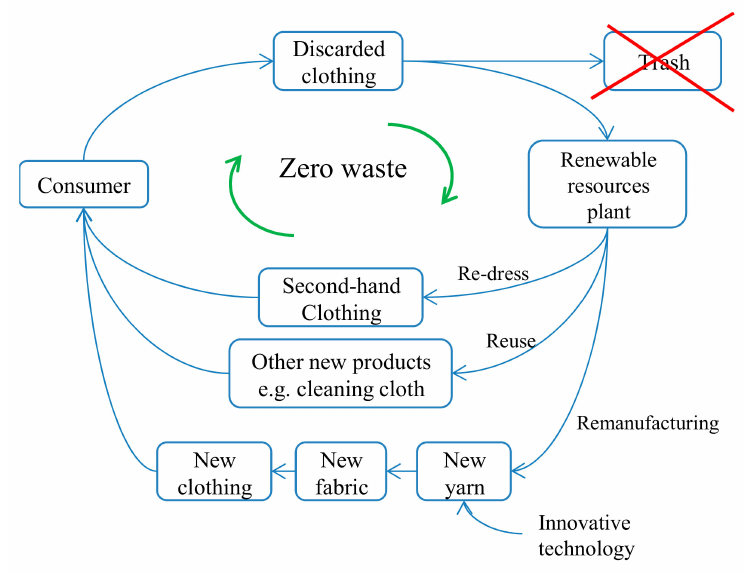
Figure 1. Circulation of waste